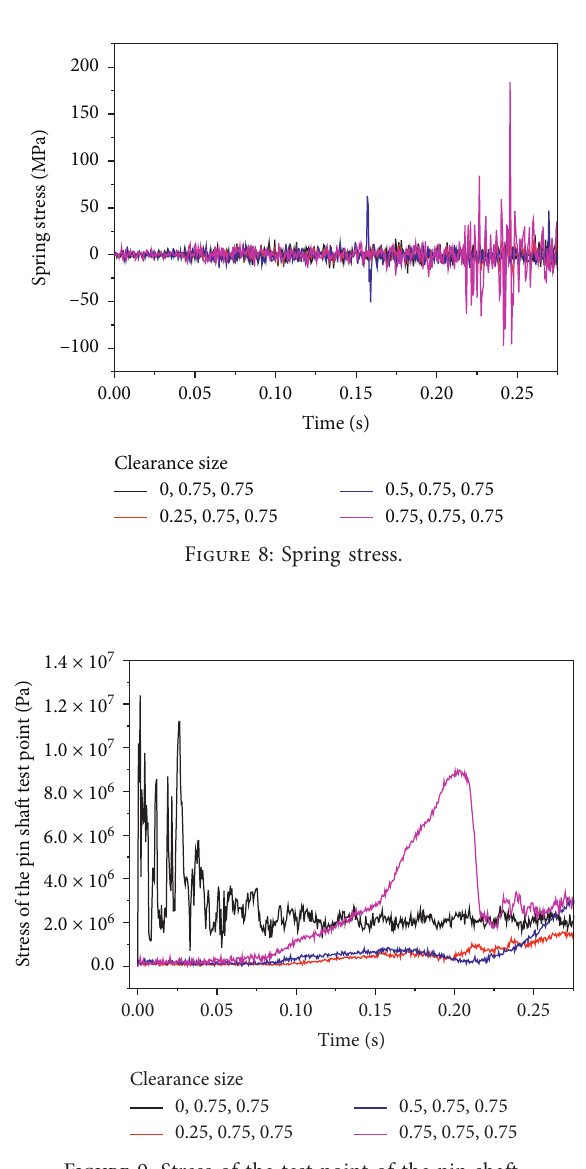
Figure 11: Velocity of the tail beam test